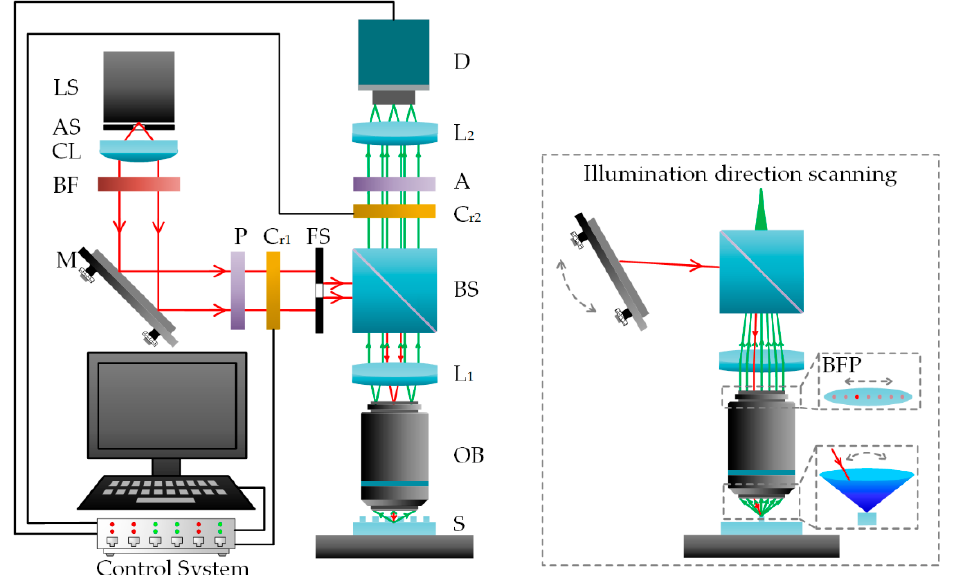
Figure 1. Scheme of the tomographic Mueller-matrix scatterometer (TMS). LS, light source; AS, aperture stop; CL, collimated lens; BF, bandpass filter; M, mirror; P and A, polarizer and analyzer; C r1 and C r2 , 1st and 2nd rotating compensators; FS, field stop; BS, Beam splitter; L 1 and L 2 , imaging lenses; OB, objective lens; S, sample; D, detector. The inset on the right side illustrates the principle of illumination direction scanning.